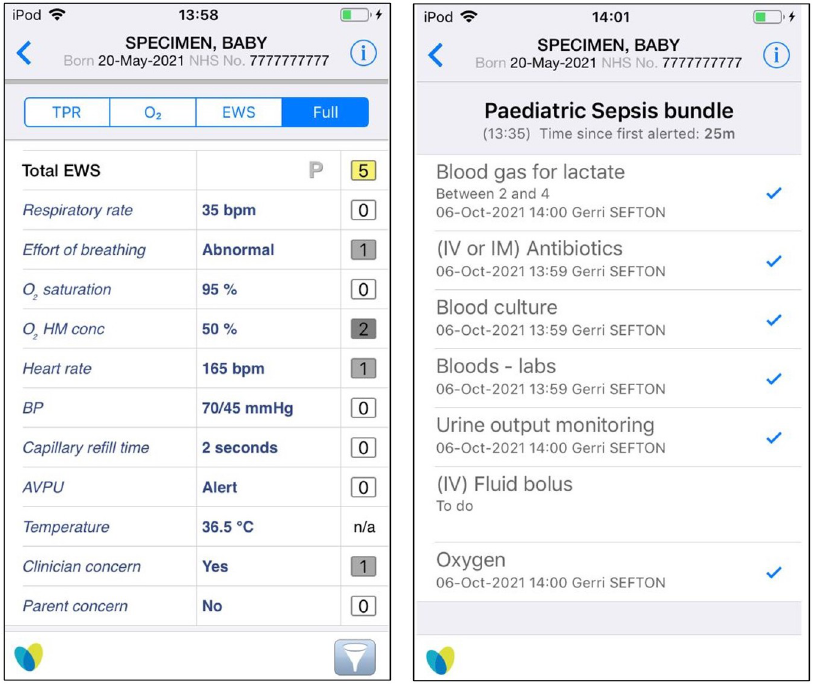
Fig 2. Example screenshots from iPod touch: DETECT e-PEW score screen and sepsis bundle overview (fictitious patient data).